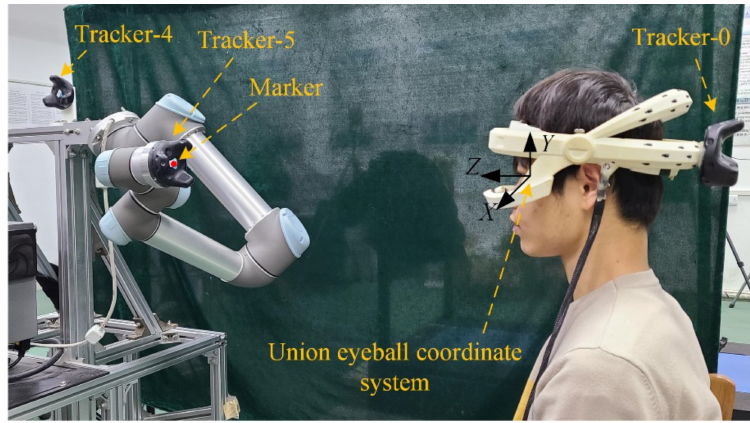
Figure 6. Calibration setup utilizing a UR robot arm and 6D pose